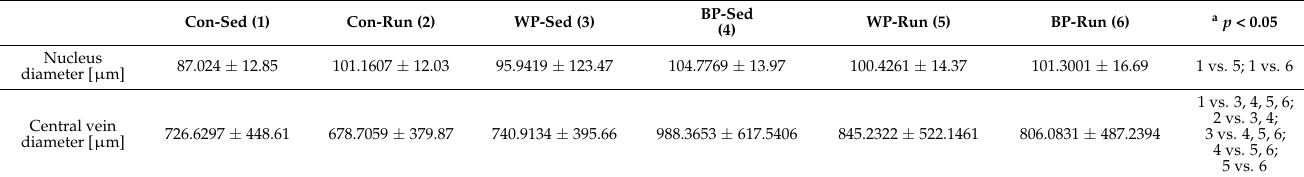
Table 2. The evaluation of nucleus and central vein diameter by groups.